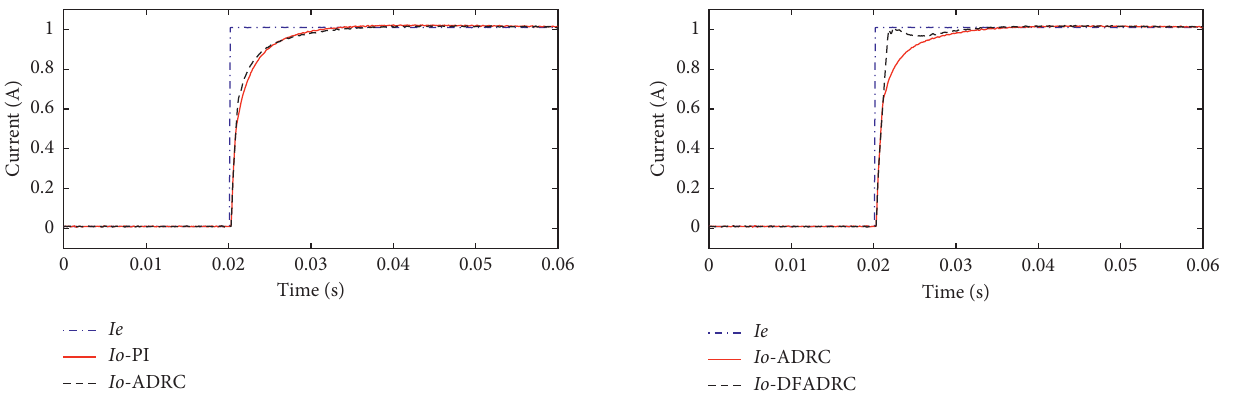
Figure 16: The results comparisons between PI and ADRC under step input (1A).